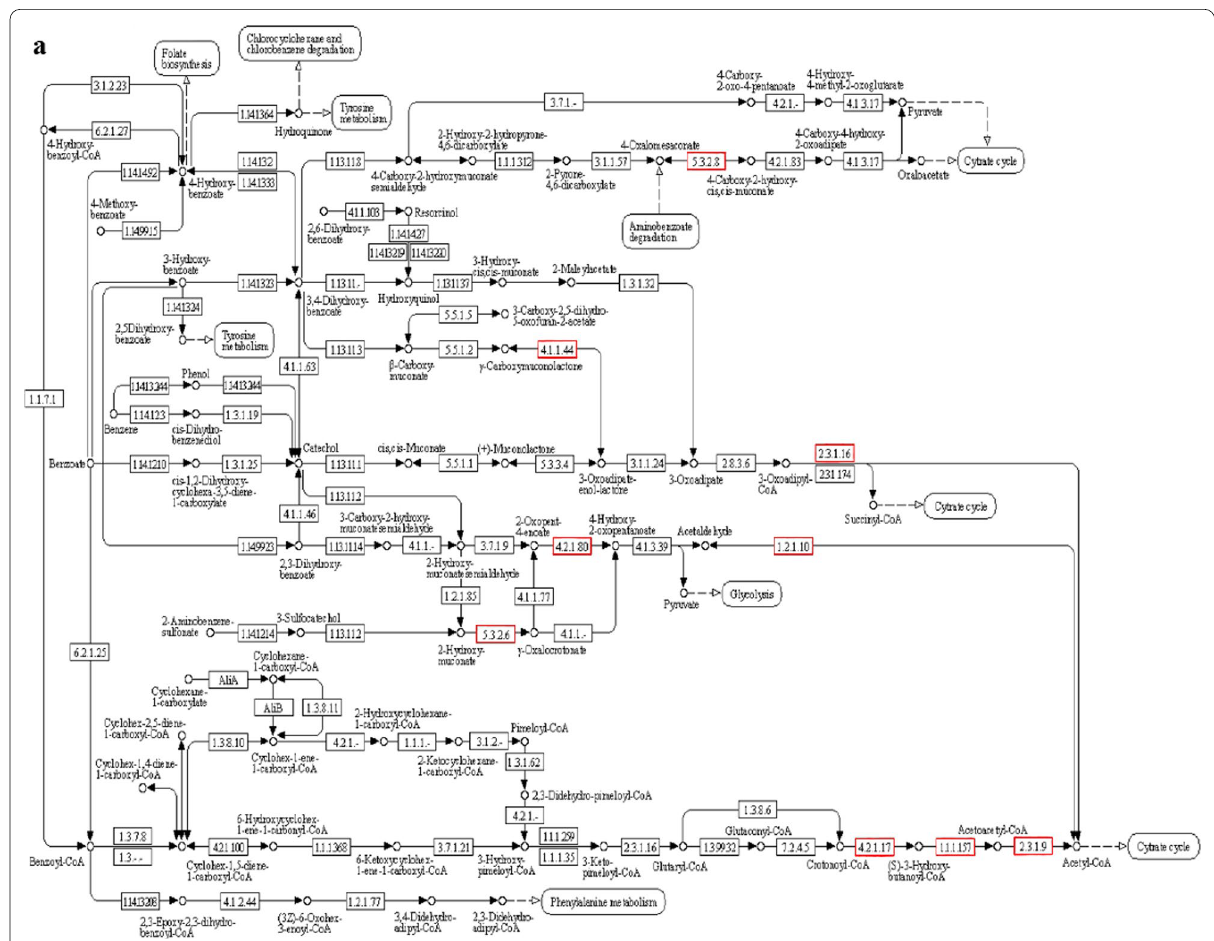
Fig. 4 a Degradation pathway of benzoate. b Biosynthetic pathway of streptomycin. The red boxes represent the key genes contained in strain